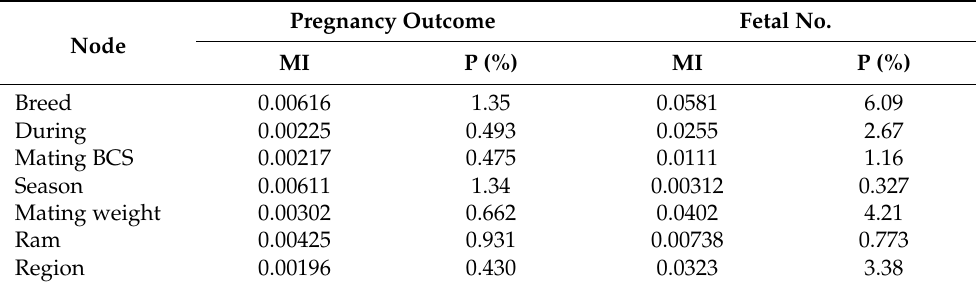
Table 2. Bayesian network sensitivity analysis to determine how much the pregnancy outcome and fetal number (no.) nodes (variables) were influenced by each of the observed nodes. Fetal number is for positive pregnancy outcomes (‘1’ was selected in pregnancy outcome node and the fetal number (‘litter size’) sensitivity analysis performed, Figure 1). Mutual information is represented by MI and percentage by P (%). Data displayed to three significant figures (rather than decimal places). Pregnancy Outcome Fetal No. Node MI P (%) MI P (%) Breed 0.00616